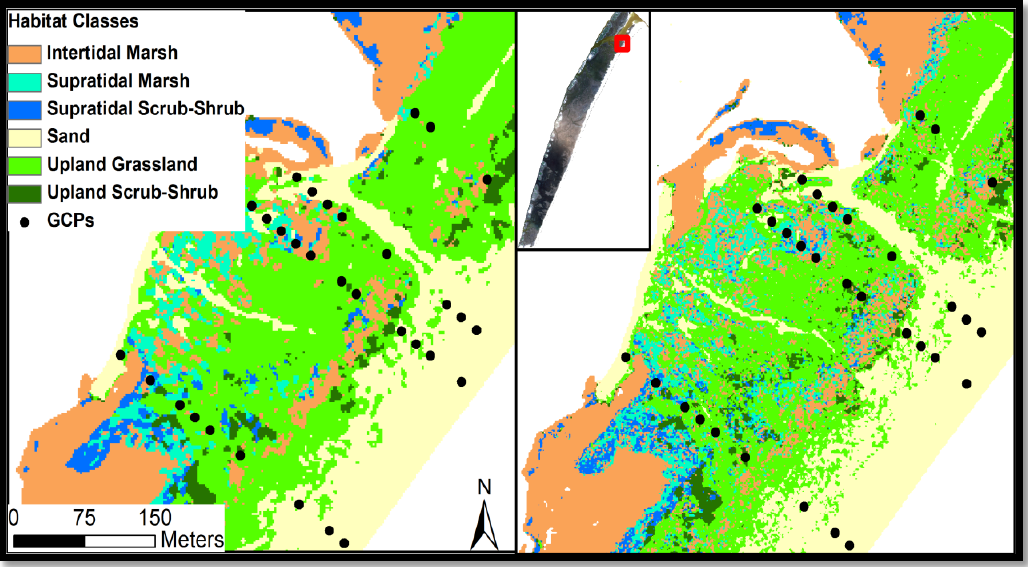
Figure 5. Pan-sharpened and non-sharpened maps for a portion of the northern beach area. On the left is WV-2 supervised, 8 band, majority filtered, non-sharpened at 1.8 m spatial resolution (72.56% accurate) and on the right is the same image processing with pan-sharpening at 0.5 m spatial resolution (65.85%